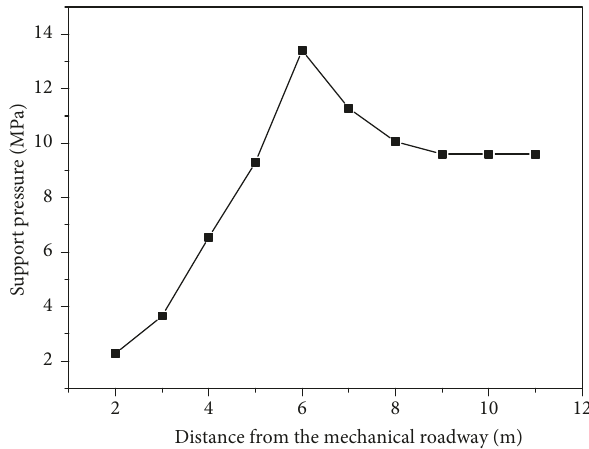
Figure 22: Lateral bearing pressure distribution on working face.